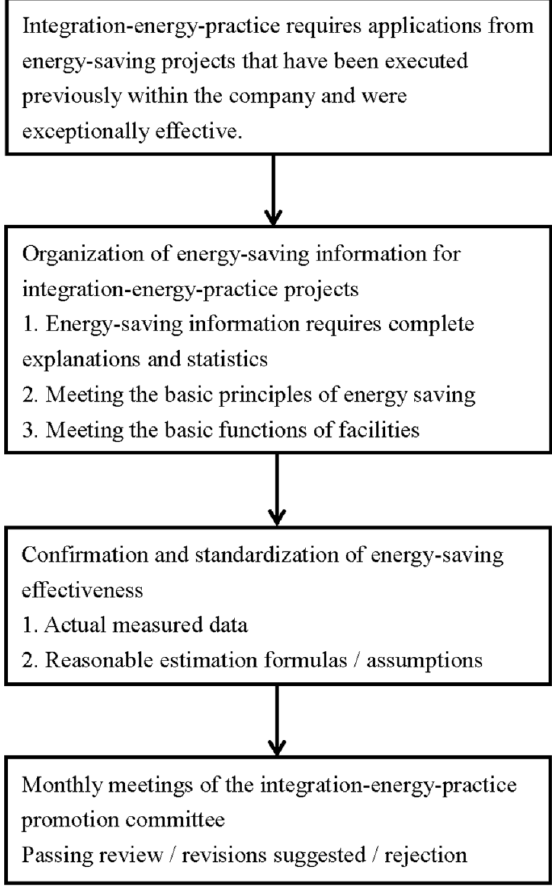
Figure 2. Integration-energy-practice model application review principles and processes.